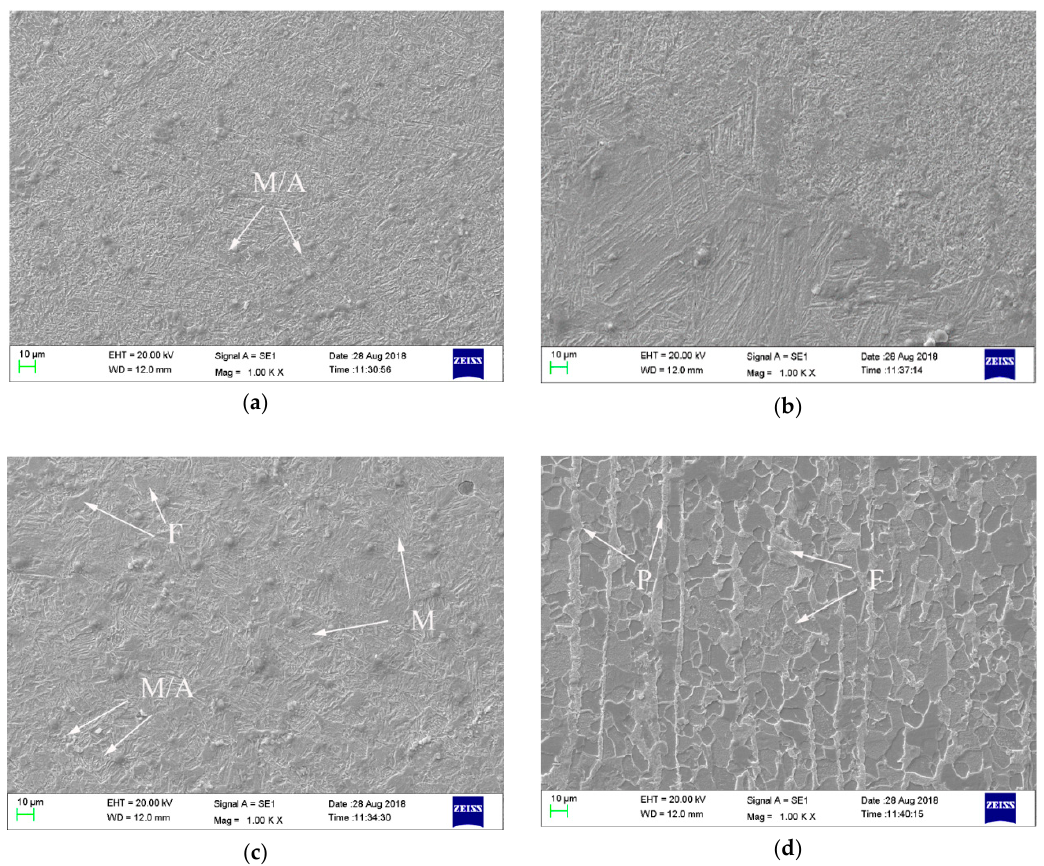
Figure 4. Microstructure of cruciform welded joints (the spherical particles in the figures are residual polished sand): ( a ) WZ, ( b ) FZ, ( c ) HAZ, and ( d ) BM.